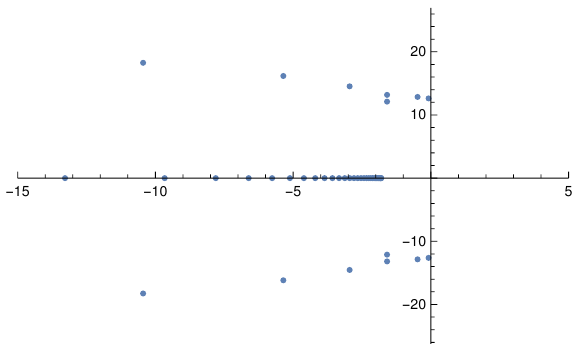
Figure 18. Poles of the integrand of (C.30) on the Borel (cid:16) -plane for t =